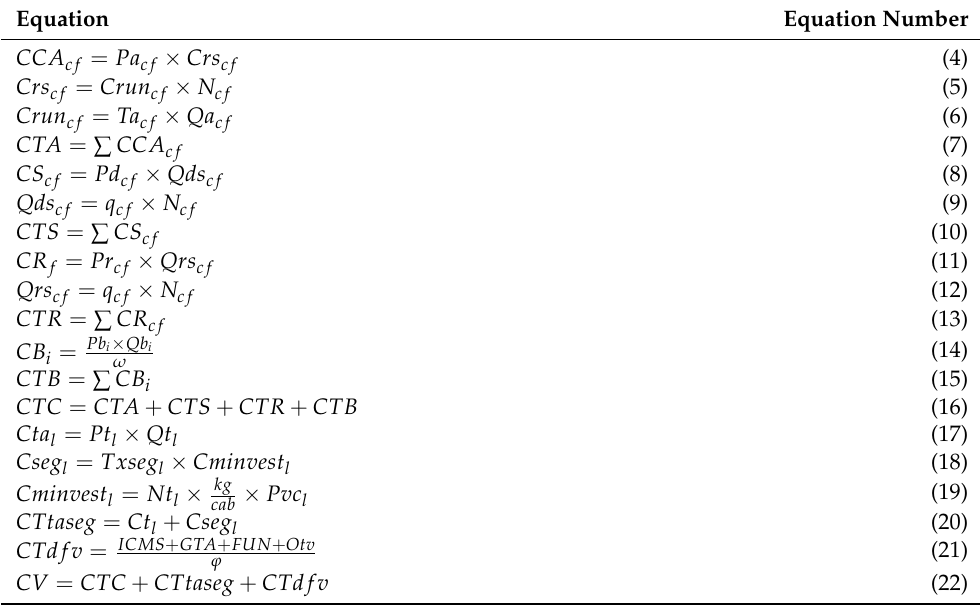
Table 2. Equations that make up the variable costs that compose the cost calculation model for swine production.